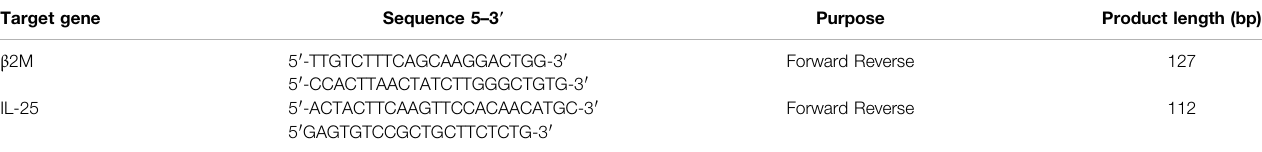
TABLE 1 | Primer sequences used in real-time quantitative reverse transcriptase polymerase chain reaction analysis.